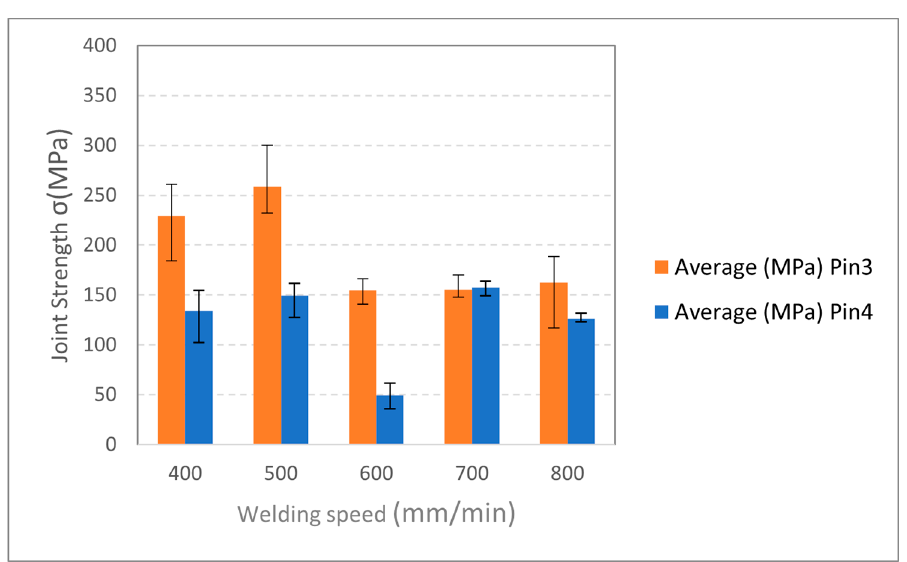
Figure 7. Comparison of Pin3 and Pin4 tool at 2000 rpm.